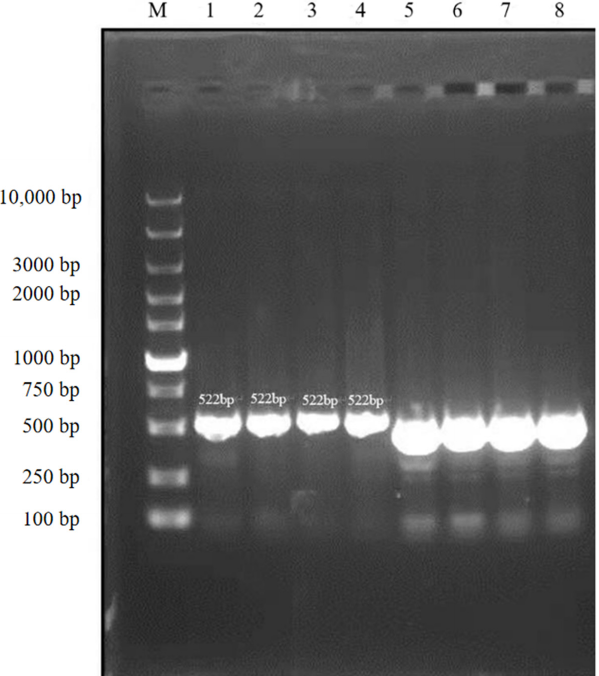
Figure 3. Agarose gel electrophoresis (cropped).